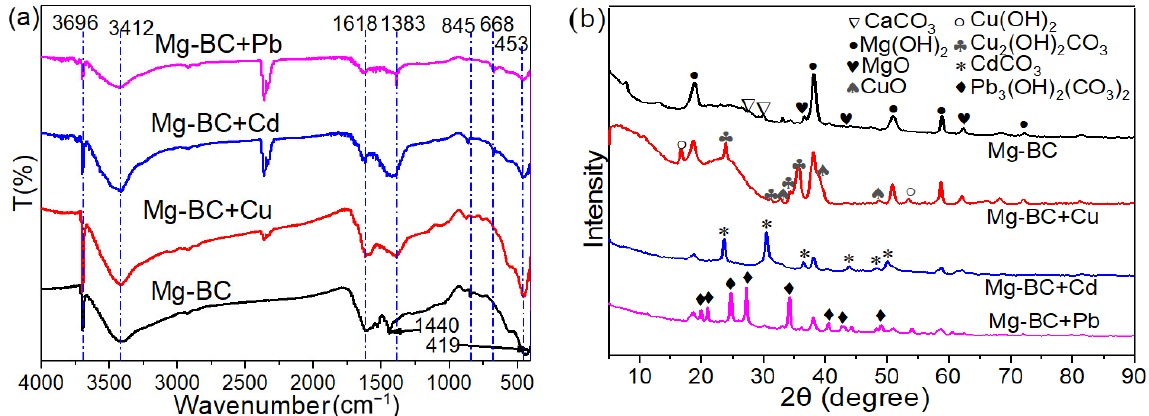
Figure 7. FTIR spectra ( a ) and X-ray diffractometry (XRD) patterns ( b ) before and after metal adsorption onto 15%Mg-BC.